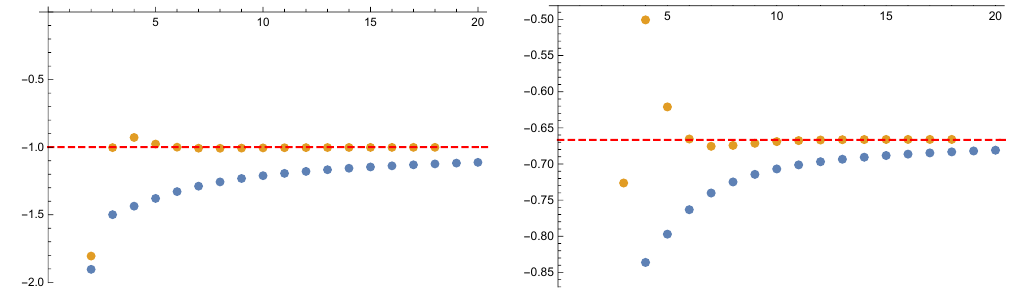
Figure 4 . The (cid:12)gure in the left (respectively, right) shows the analogue of the sequence (3.29) with instead of , as well as its second Richardson transform, for the O( N ) sigma model with D k S k N = 4 and N = 5, respectively. The horizontal dashed line is the expected value